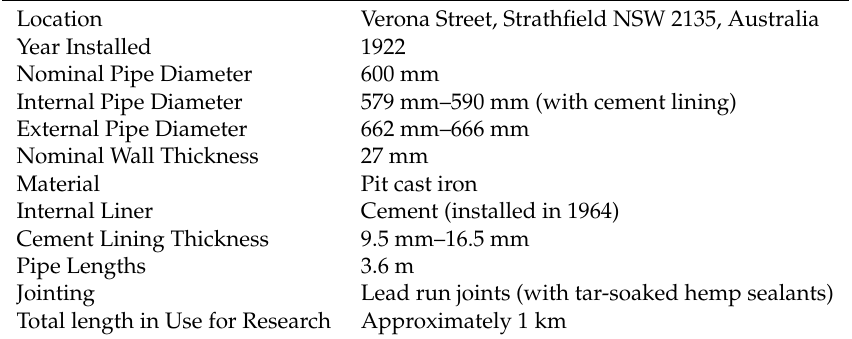
Table 1. Specifications of the grey cast iron pipe used for the experimental work of this paper; adapted from